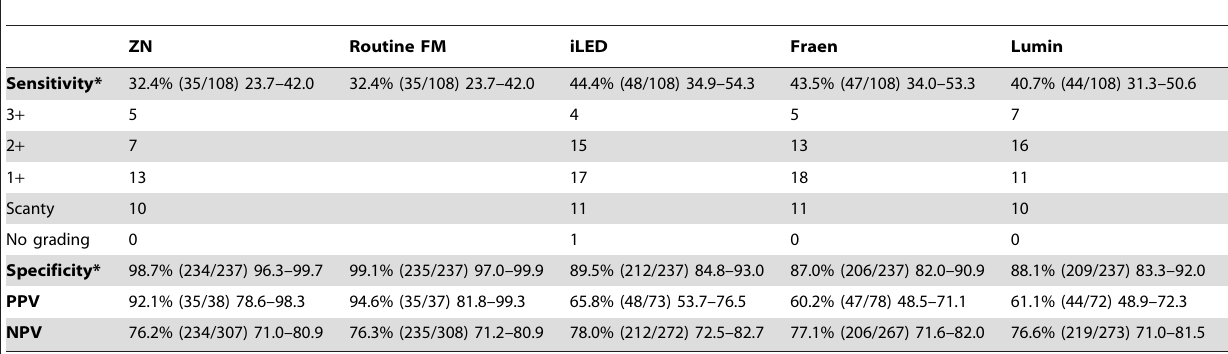
Table 2. Performance of three LED-based fluorescence microscopy devices in detection of tuberculosis in HIV-positive suspects in Kampala, Uganda, per patient